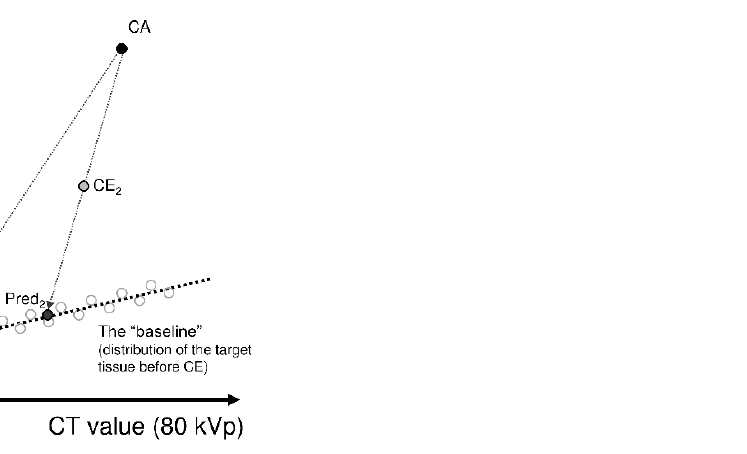
Figure 1. Overview of iodine concentration estimation from post-contrast-enhanced dual-energy computed tomography (DECT). When the CT values for the two energy levels of DECT can be assumed to be linearly correlated in the target tissue without contrast enhancement (the “baseline”), the measured CT values after contrast enhancement (CE 1 , CE 2 ) can be considered to have deviated from somewhere on the baseline toward the point of iodine contrast agent (CA). Therefore, the CT values before contrast enhancement can be predicted (pred 1 , pred 2 ) by obtaining the intersection of the baseline and the line connecting CA and CE 1 , CE 2 , respectively. In addition, iodine concentration can be estimated by determining the difference between CE 1 and pred 1 , as well as that between CE 2 and pred 2 .